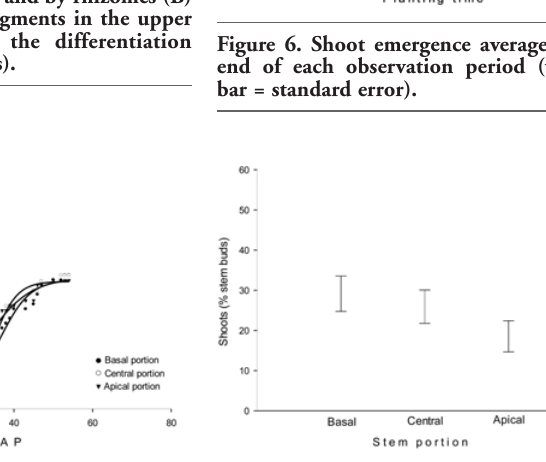
Figure 7. Shoot emergence average of com- pared stem portions at the end of observa- tions (vertical bar = standard